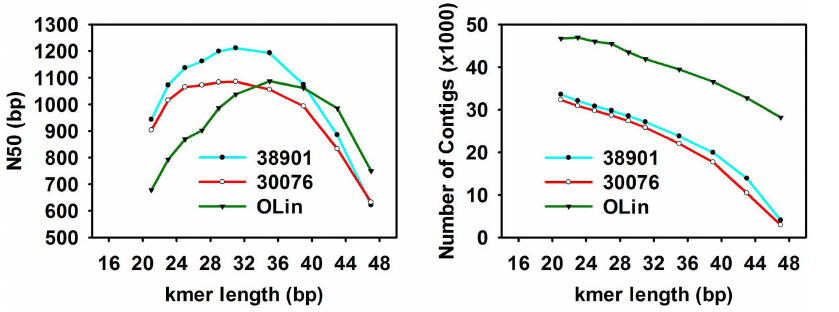
Fig. 2. N50 and total length of the assemblies produced by AByss with different kmers. A) N50, B) contig